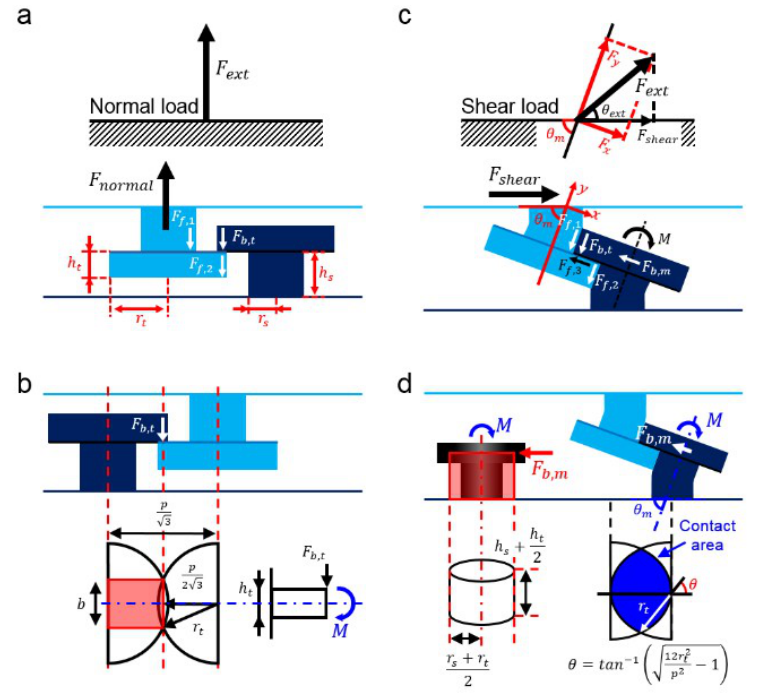
Figure 4. ( a ) A model system of the interlocked microstructures under a normal loading; ( b ) A schematic illustration describing the geometry of the microstructure and the bending force acting on the tip of the microstructures ( F b,t ); ( c ) A model system of the interlocked microstructures under a shear loading; ( d ) A schematic illustration describing the geometry of the microstructures and the bending force acting on the microstructures ( F b,m ). Table 2. Estimated values of each parameter and force used for the theoretical calculation of the interlocking adhesion.